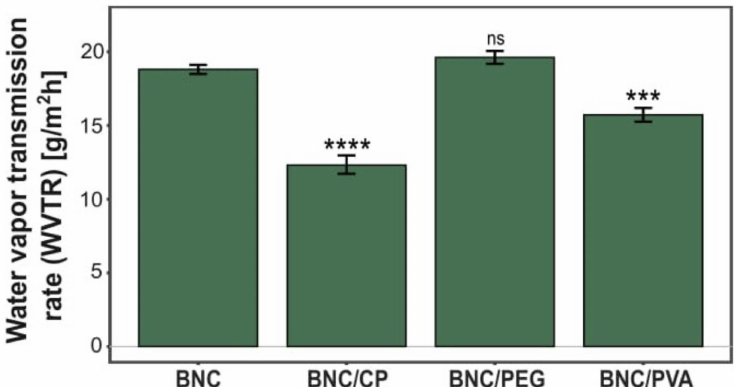
Figure 12. Water vapor transmission rate (WVTR) of native and modified BNC films produced by the strain isolated from balsamic vinegar (12Et). Statistically significant differences were calculated using a one-way ANOVA with Tukey’s multiple comparison post-hoc test and are shown as *** = p ≤ 0.001, and **** = p ≤ 0.0001, compared to control (native) membranes.